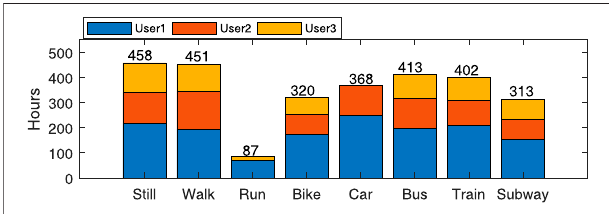
FIGURE 2 | The duration of each of the eight transportation activities by the three participants in the complete SHL dataset. The total duration of the annotated data is 2,812 h.